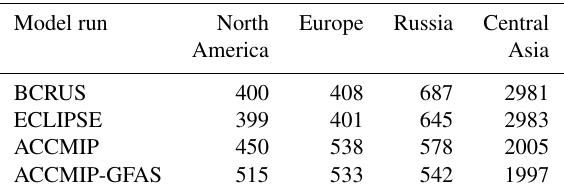
Table 3. Area-weighted totals of BC emissions from anthropogenic sources and biomass burning fires for the main source regions (as shown in Fig. 1) averaged for the years 2005–2015 (in ktyr − 1